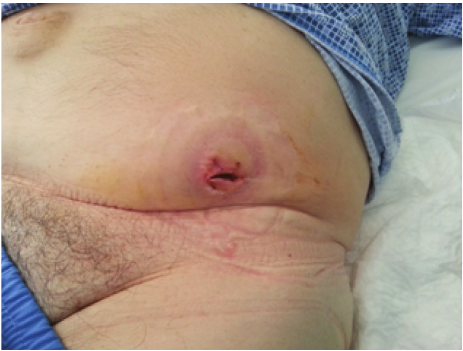
Figure 5: Photograph of the abdominal wall abscess after surgical